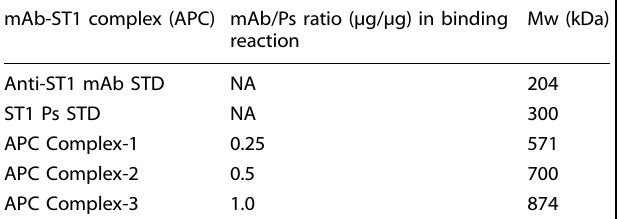
Table 1. SEC-UV-MALS-RI analysis of complexes formed by anti-ST1 mAb and ST1